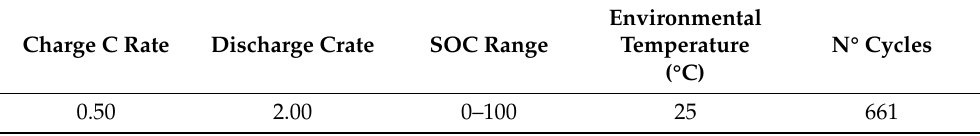
Table 2. Test operating conditions of cycle aging experiments. N° Cycles is the number of charge and discharge cycles that a cell can process before it reaches its end-of-life condition (20% of capacity loss).